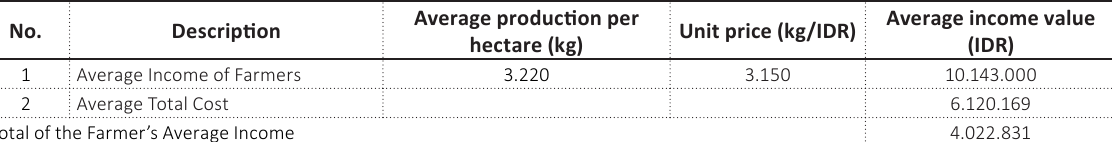
Table 4. Analysis of corn producer average income per ha/planting